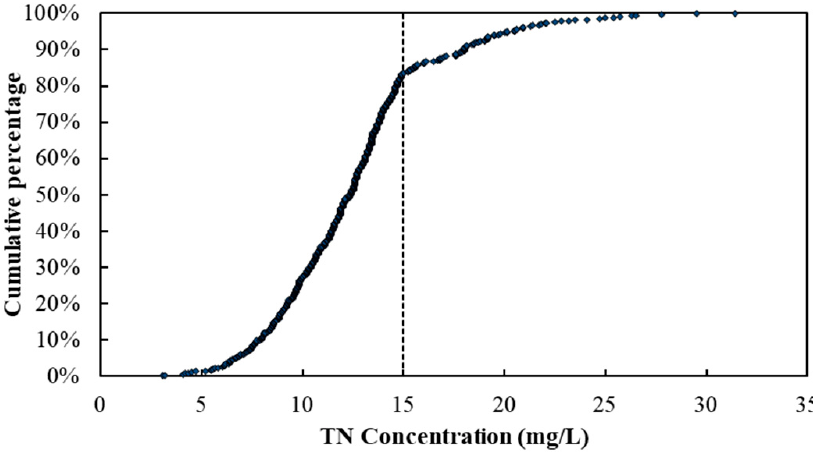
Figure 4. Total nitrogen cumulative distribution of the effluent in the CAST process.